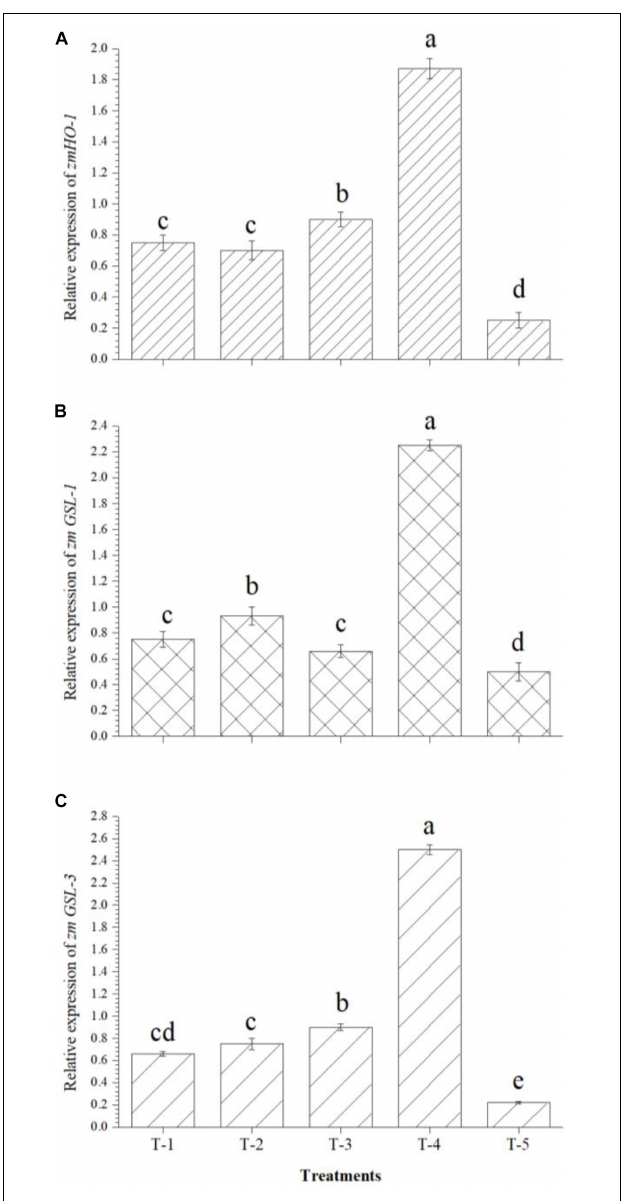
FIGURE 3 | Effects of seed bio-inoculation on expression profile of genes (fold change) related to primary and secondary rooting in the maize roots grown in saline sodic soil at 30 days of sowing. (A) Relative expression of zmHO-1 , (B) relative expression of zmGSL-1 , and (C) relative expression of zmGSL-3 . Treatments were as follows: T 1 — B. safensis MF-01, T 2 — B. altitudinis MF-15, T 3 — B. velezensis MF-08, T 4 — B. safensis MF-01 + B. velezensis MF-08 + B. altitudinis MF-15, and T 5 —control (untreated). Data are mean ( n = 10) and vertical bar represents standard deviation. Data with different letters show significant difference in column data in randomized block design test at p < 0 . 05 under Duncan’s multiple range